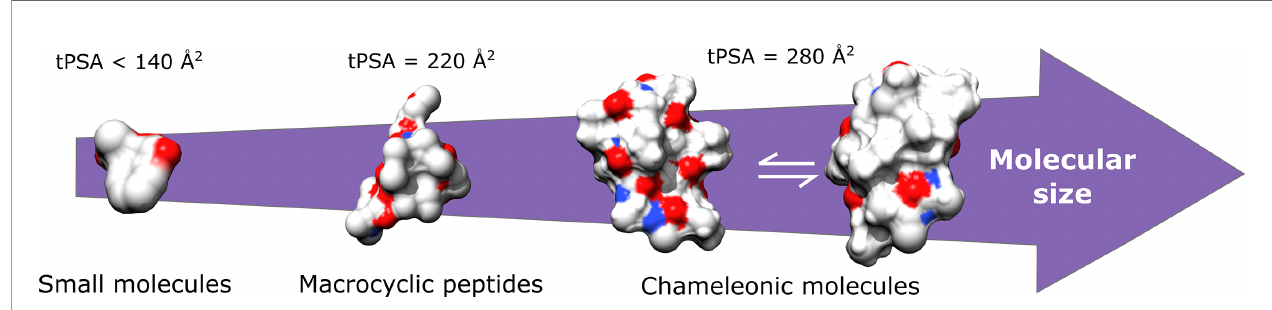
FIGURE 3 | Acceptable tPSA values for the cell membrane permeability. Chameleonic molecules are able to change their conformation to expose polar groups in an aqueous phase, however hide them when translocating through the